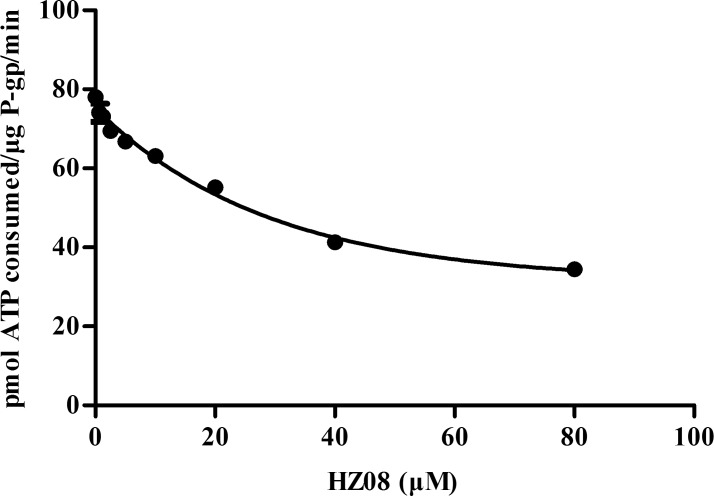
HZ08 inhibition of VER-stimulated P-gp ATPase activity.P-gp ATPase assays were performed according to the instruction of P-gp-Glo™ Assay Systems. Each point represents the mean±SD for triplated independent determinations.